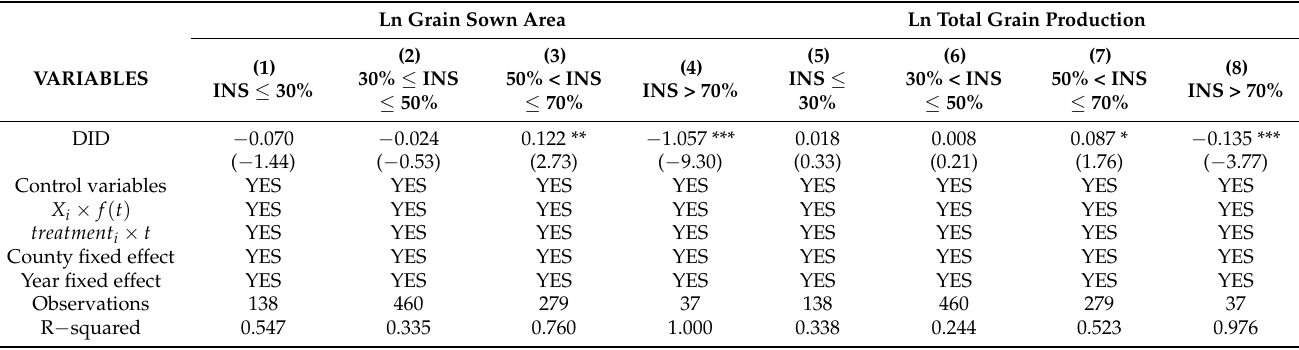
Table 8. Differences in industrial structure.